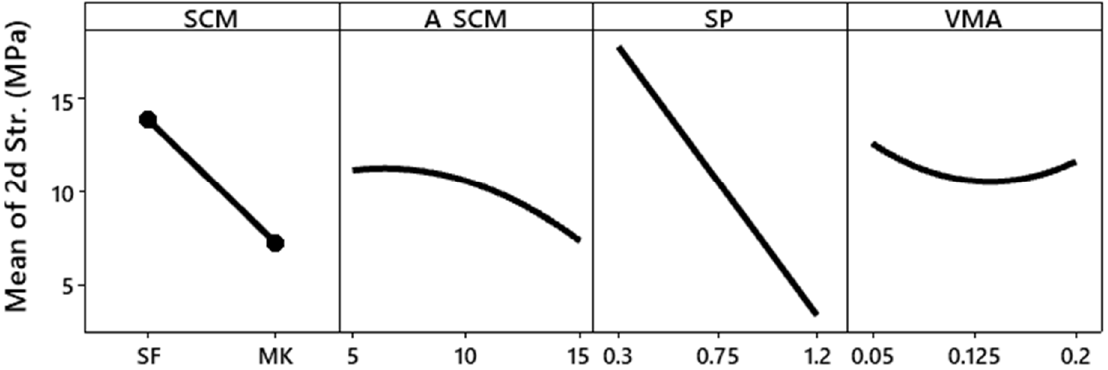
Figure 5. Pareto chart of the standardized effects for 2-day ( a ) and 28-day compressive strength ( b ).